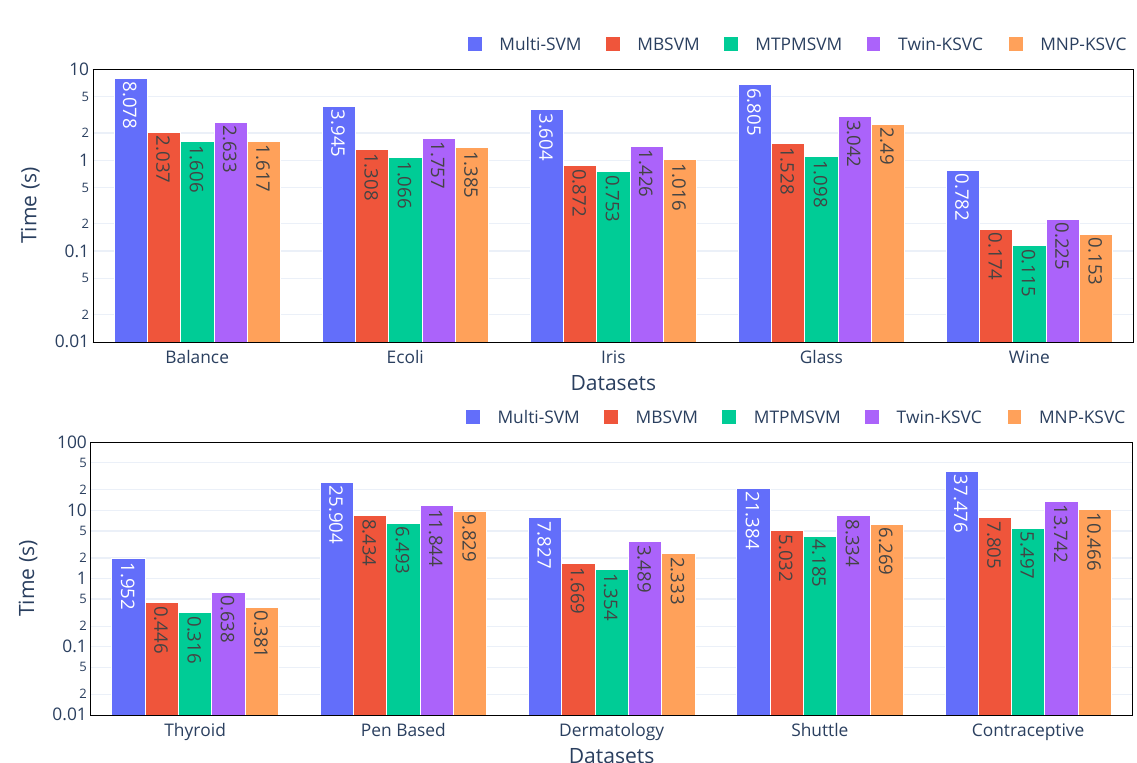
Figure 2. The learning times on benchmark datasets for linear classifiers.